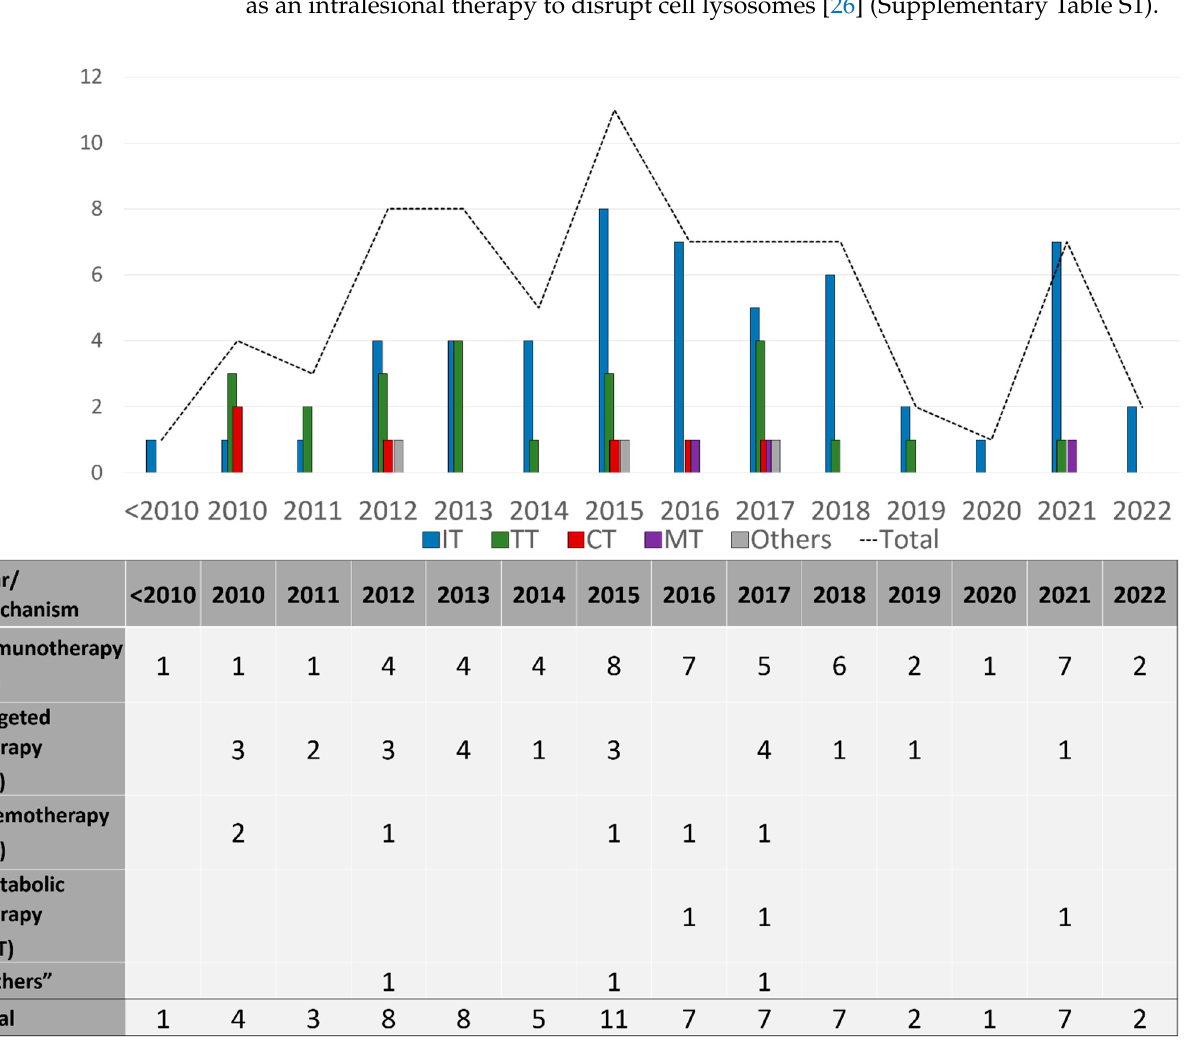
Figure 3. Number of late-stage phase 3 trials initiated each year, categorized by drug category.